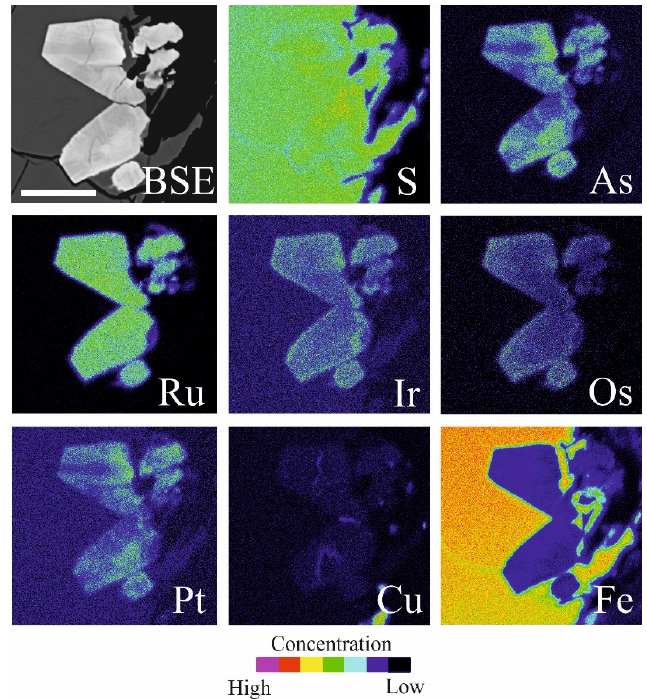
Figure 6. BSE image and X-ray element-distribution maps of S, As, Ru, Ir, Os, Pt, Cu, and Fe in zoned laurite from the Merensky Reef. See Figures 3B and 4A for the paragenetic assemblage. Scale bar = 20 µm. Minerals 2020 , 10 , x FOR PEER REVIEW